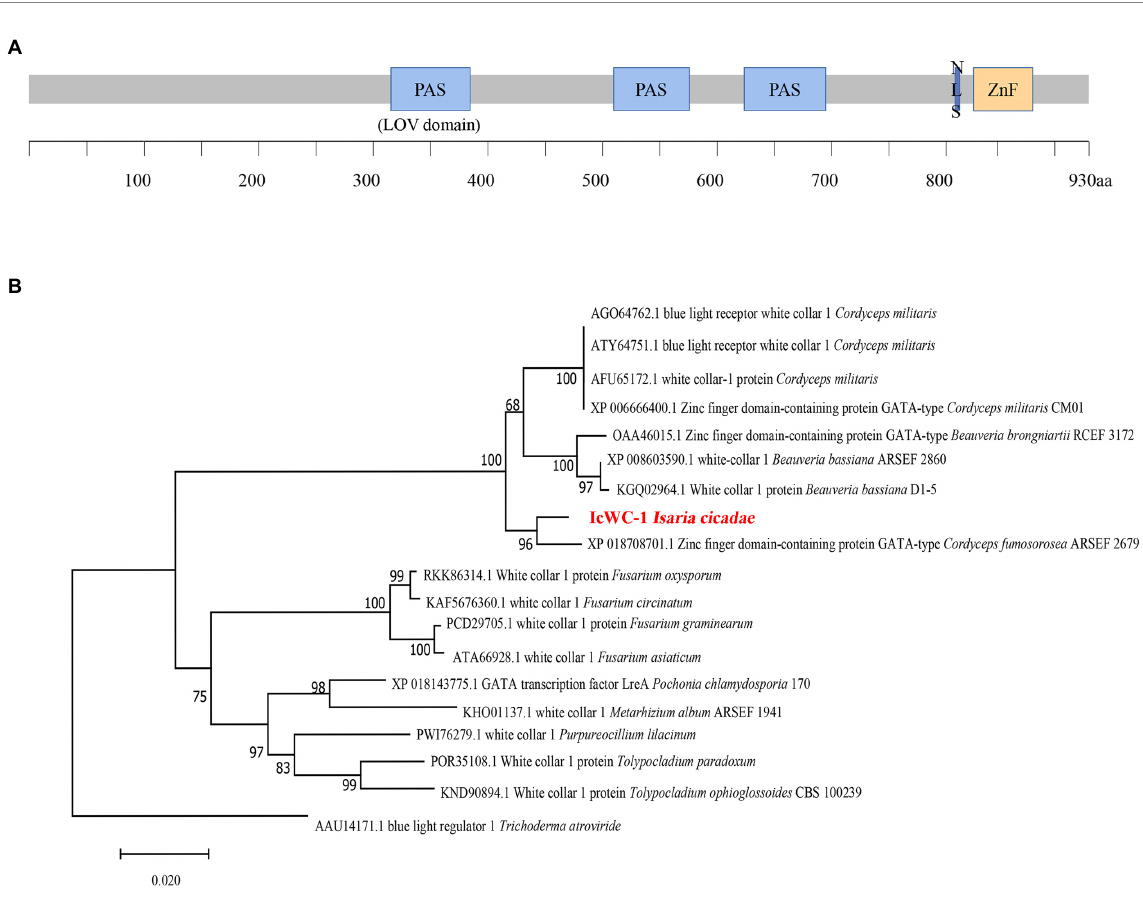
Δ Icwc-1 mutant. The RT-PCR analysis showed that Icwc-1 was not expressed in mutant ∆ Icwc-1 , while the expression of the wc-1 gene in the complementary strain ∆ Icwc-1 -C was restored